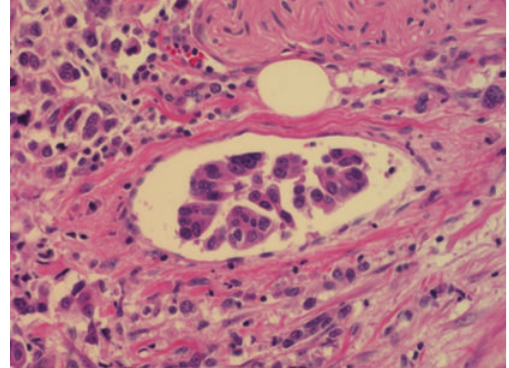
Figure 3: The tumor cells show high nuclear grade and reversed